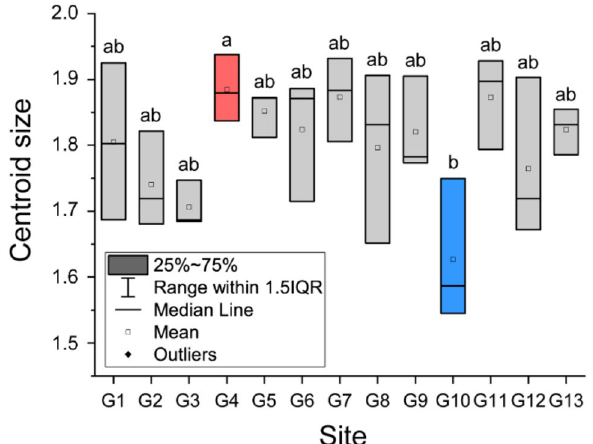
Figure 4. Comparison of centroid sizes in yellow-legged hornets based on landmark morphometrics analysis. The lines of the box graph represent the first quartile, median, and third quartile of the yellow-legged hornet. The transparent boxes represent average values. Lowercase letter and box color indicate differences ( p < 0.05) in centroid size based on Tukey’s post-hoc tests.